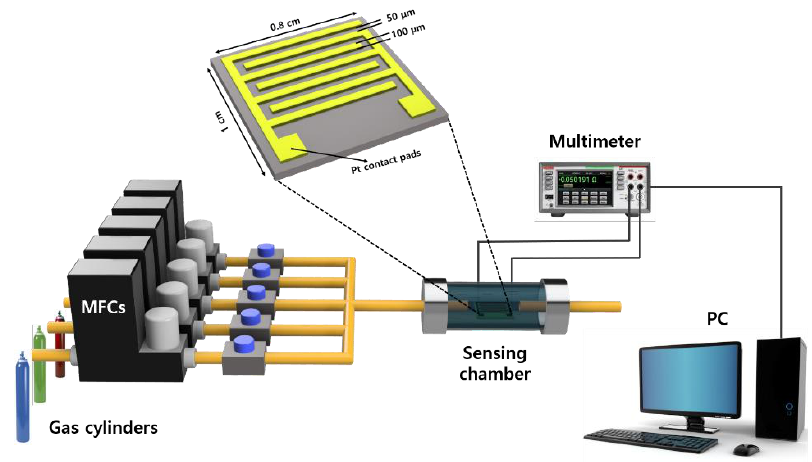
Figure 1. The schematic for gas sensing set-up along with dimensions of the gas sensor.